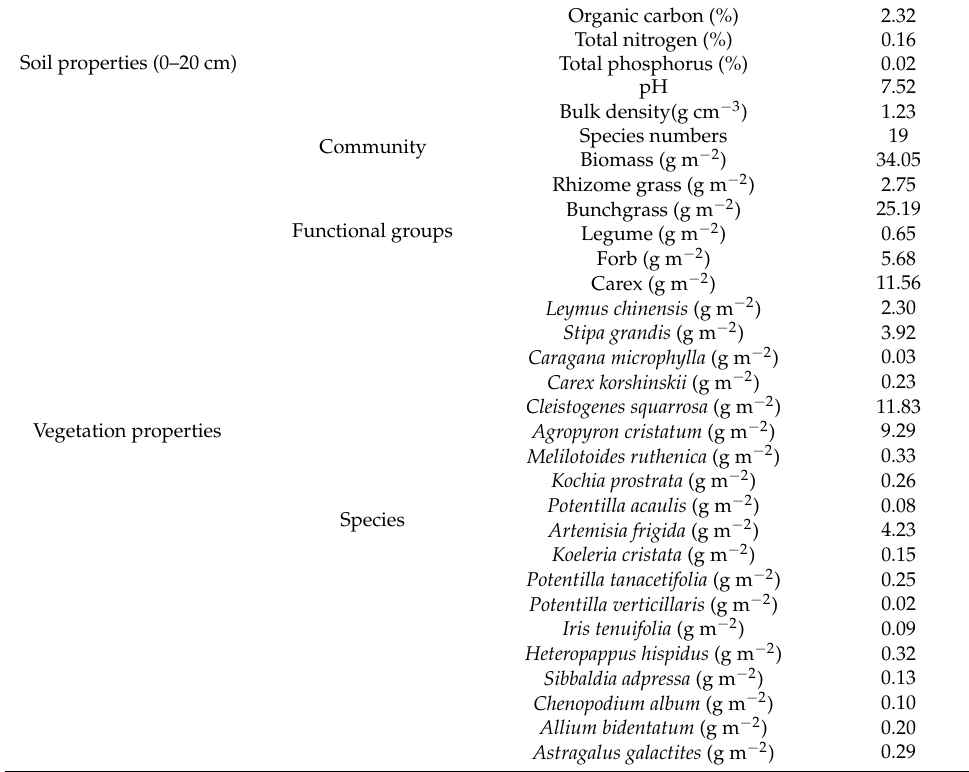
Figure 1. Annual mean precipitation and temperature from 1981 to 2017 in the study site. Table 1. Soil and vegetation properties of the study site before fencing.